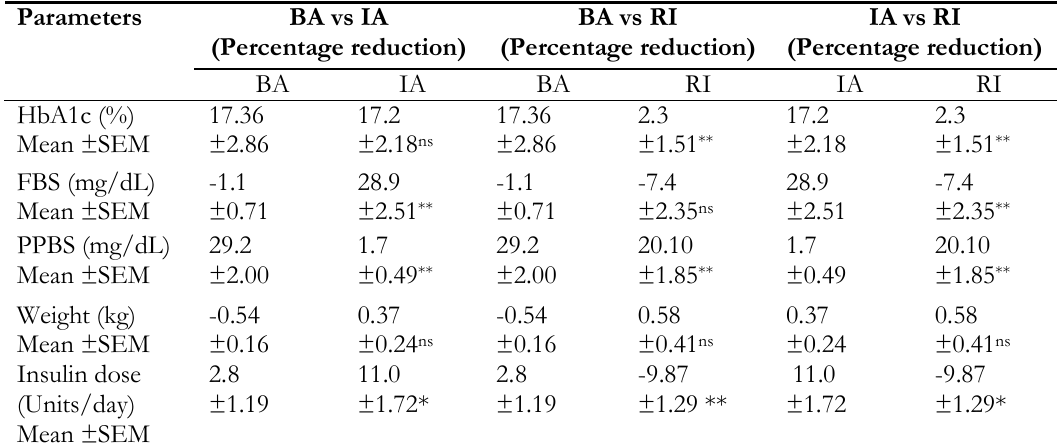
Table III. Comparison of percentage reduction of efficacy parameters between treated groups BA vs IA Parameters